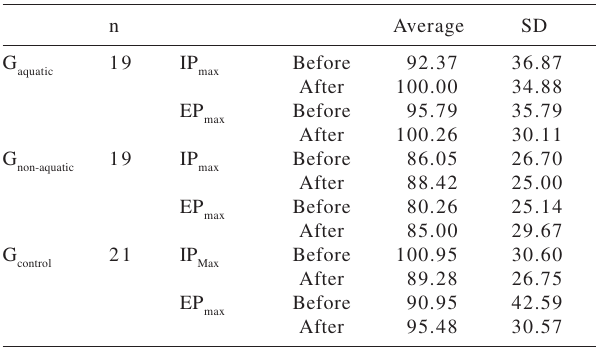
and EP after-before intervention in aquatic, non-aquatic and control groups using paired max max